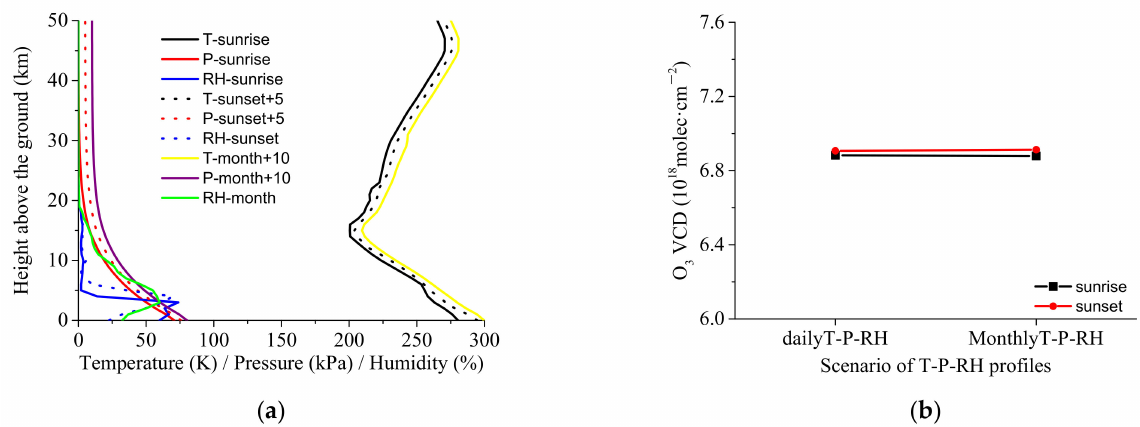
Figure 8. ( a ) Vertical profiles of temperature (T), pressure (P), and relative humidity (RH) as well as ( b ) O 3 VCDs derived from the Langley plot method. The black, red, and blue lines denote the T, P, and RH profiles derived from the operational meteorological soundings during the sunrise on 30 August 2020, respectively. The black, red, and blue dotted lines denote the corresponding T, P, and RH profiles for sunset. The yellow, purple, and green lines represent the monthly averaged T, P, and RH profiles for August 2020, using the daily sunrise and sunset T-P-RH profiles. The black curve with squares and the red curve with dots denote the O 3 VCDs during sunrise and sunset, respectively, for the daily (30 August 2020) and monthly (August 2020) T-P-RH profiles. The pressure in the figure is multiplied by a factor of 0.1. To avoid the curve coverage, the temperature and pressure for sunset and month are shifted 5 and 10 units to the right,